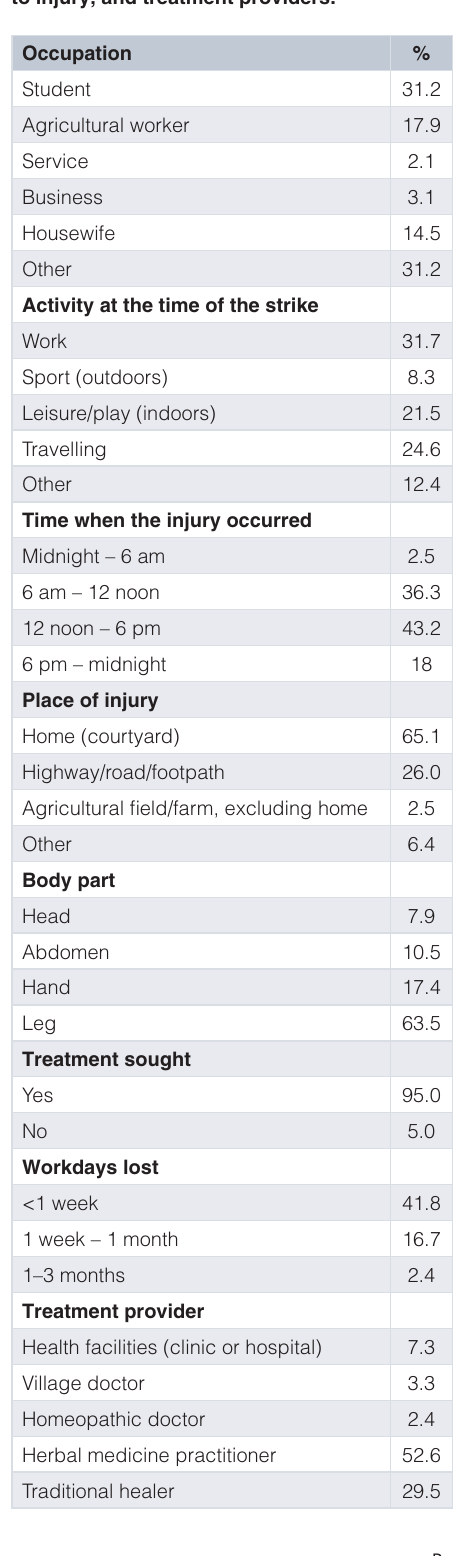
Table 2. Lightning victims’ occupation, activity at the time of the lightning strike, time when the injury occurred, place of injury, body part injured, treatment sought, workdays lost due to injury, and treatment